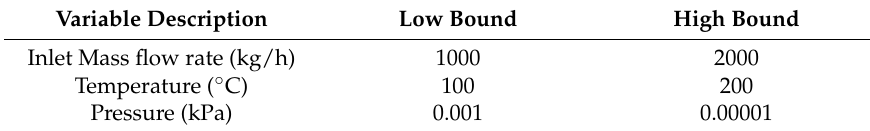
Table 10. Upper bound and lower bound for independent